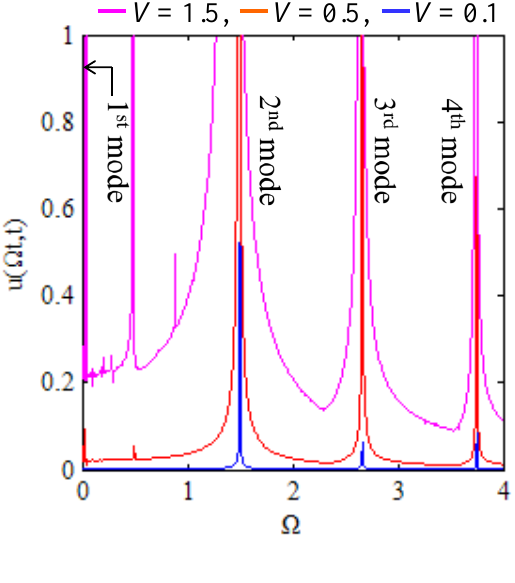
Figure 3. The frequency response of the ring at the location of traveling electrostatic